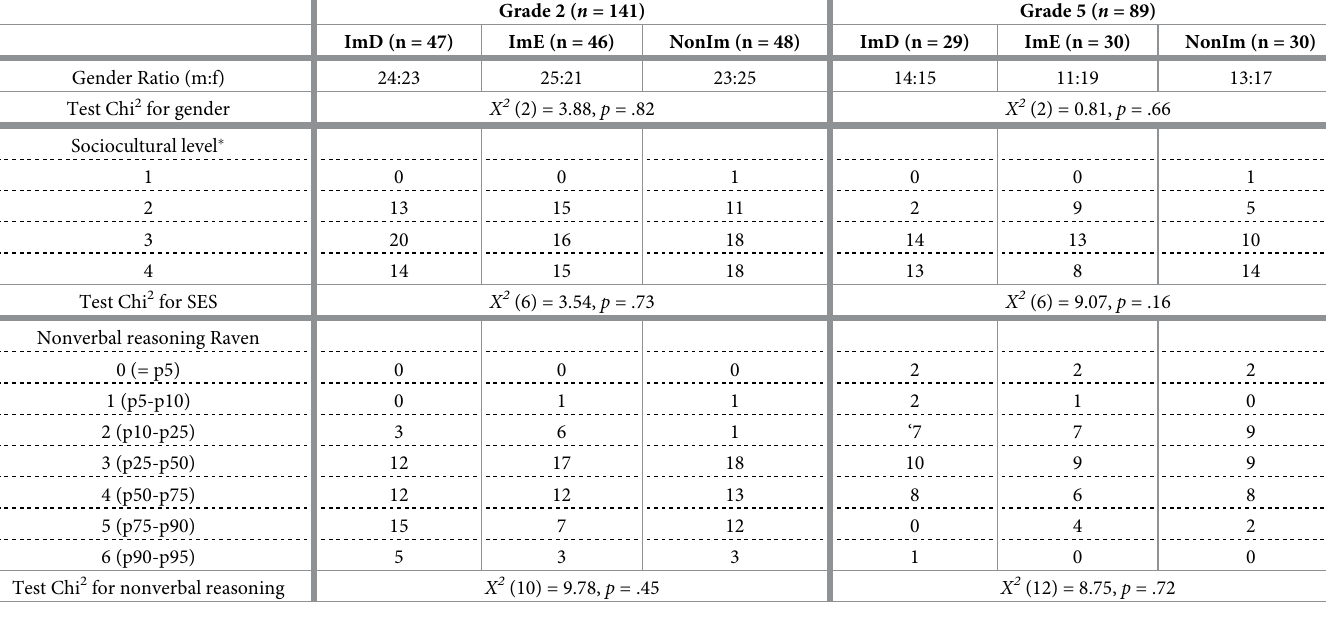
Table 1. Sample characteristics (Gender and SES), descriptive statistics, and Chi 2 for comparison in gender, SES and nonverbal reasoning indicators ( N = 230).